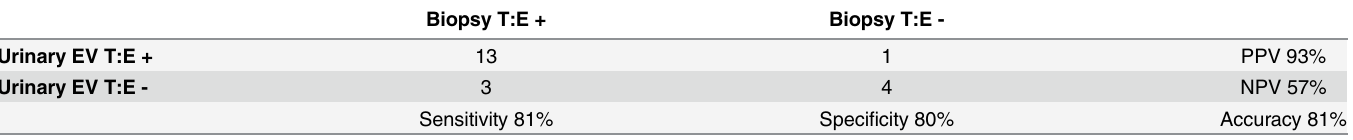
Table 2. Sensitivity, specificity, PPV, NPV and accuracy for tissue versus urinary EV TMPRSS2:ERG detection.